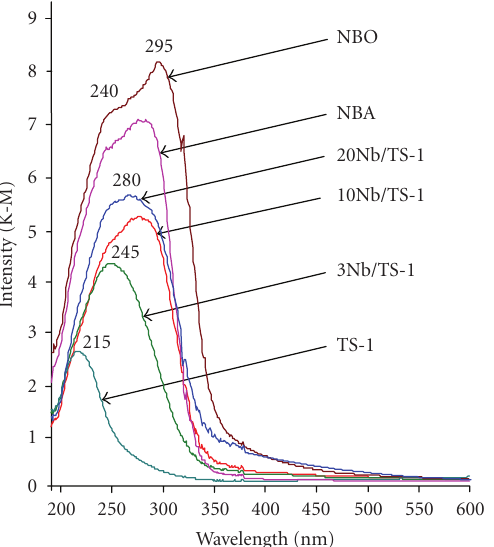
Figure 3: UV-Vis DR spectra of the NBA, NBO, TS-1, and X Nb/TS- 1 samples.